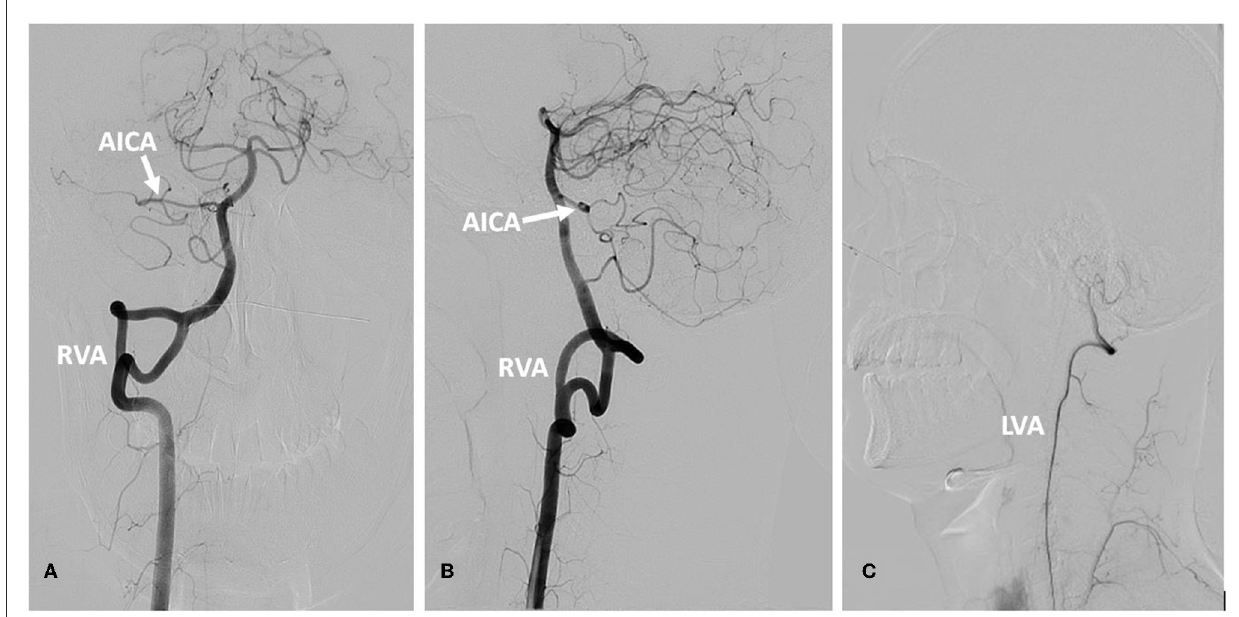
FIGURE3 DSA of the vertebral artery and basilar artery. (A) Frontal position of the RVA. (B) Lateral position of the RVA. (C) The LVA. The right vertebral artery was fenestrated, the right AICA was thick, and the left AICA was not visualized (A, B) . The LVA terminated in the PICA (C) . AICA, anterior inferior cerebellar artery; RVA, right vertebral artery; LVA, left vertebral